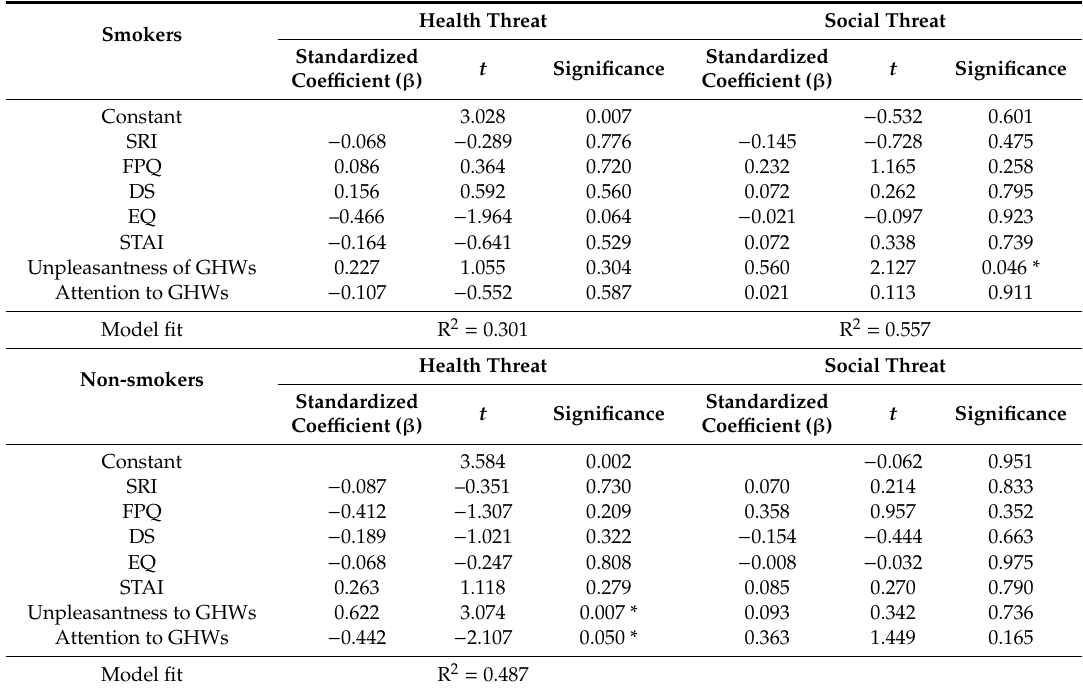
Table 2. Multiple regression analysis of the intentions to quit smoking by smokers and to maintain a non-smoking status in